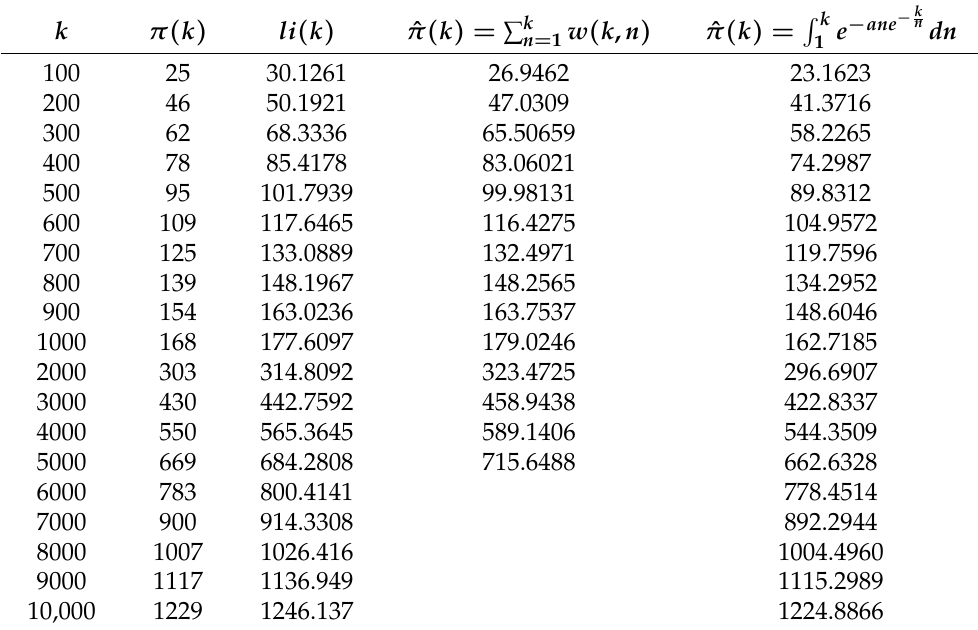
Table 3. ˆ π ( k ) estimate through recursive and continuous